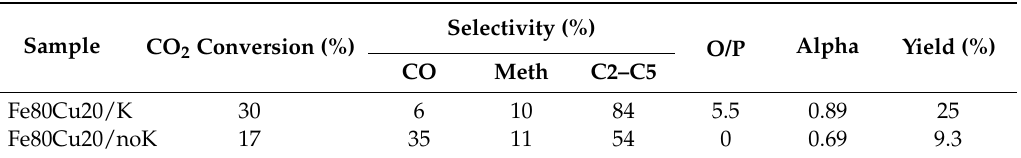
Table 2. Effects of K on FeCu/K